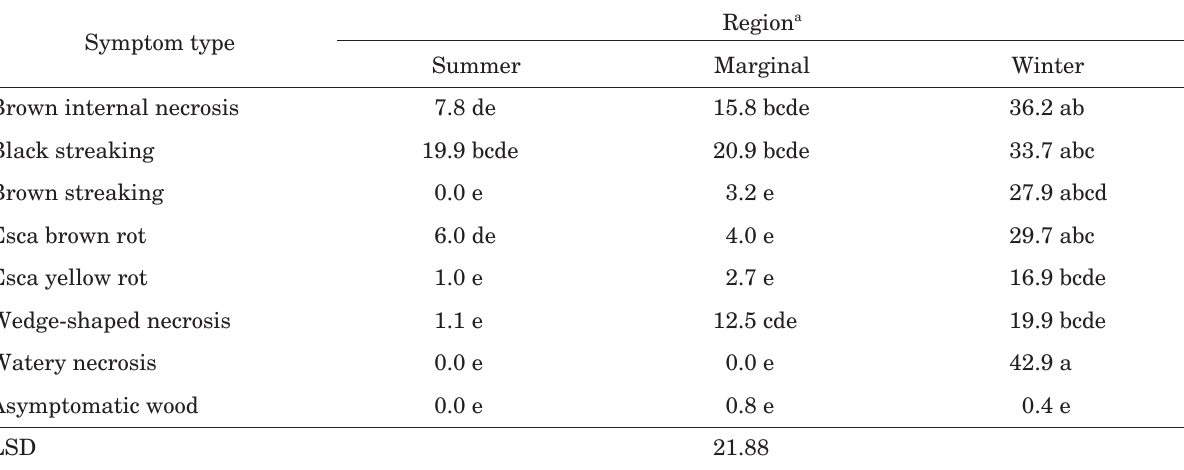
Table 2. Mean incidence of Phaeomoniella chlamydospora in isolates from vines displaying different symptoms in the summer, marginal and winter rainfall regions of South Africa.